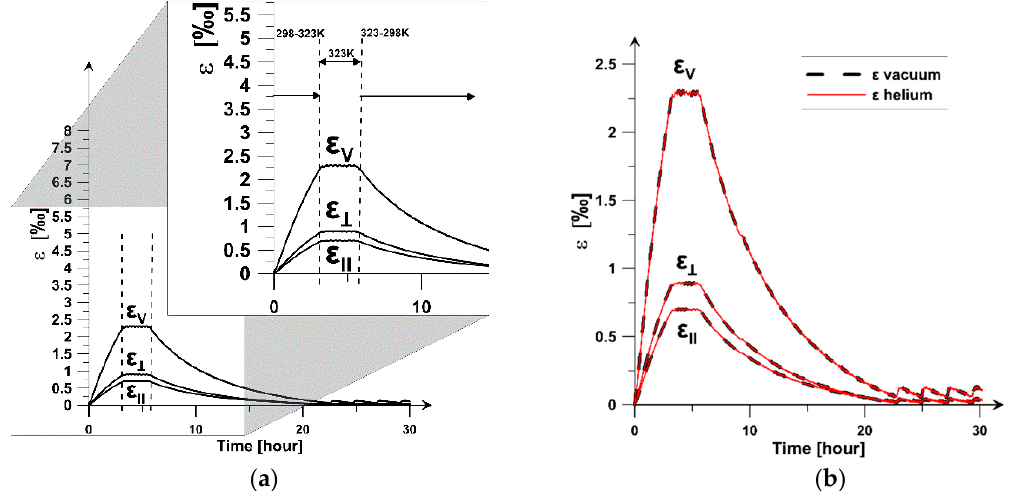
Figure 6. Thermal expansion of the coal sample ( a ) in the vacuum, and ( b ) in the vacuum and in the helium atmosphere.